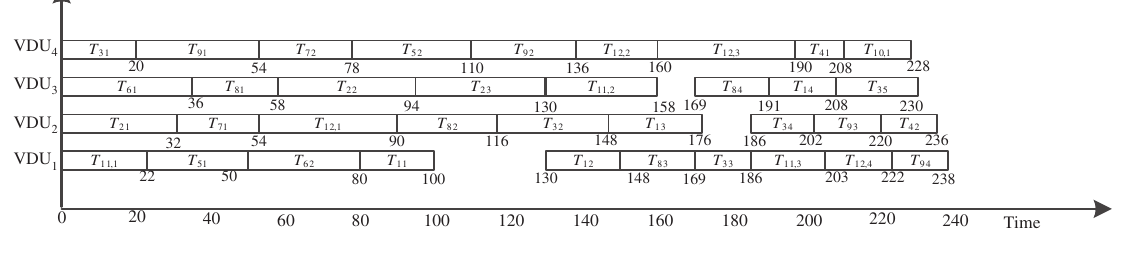
Figure 8: Gantt Chart of CETS.